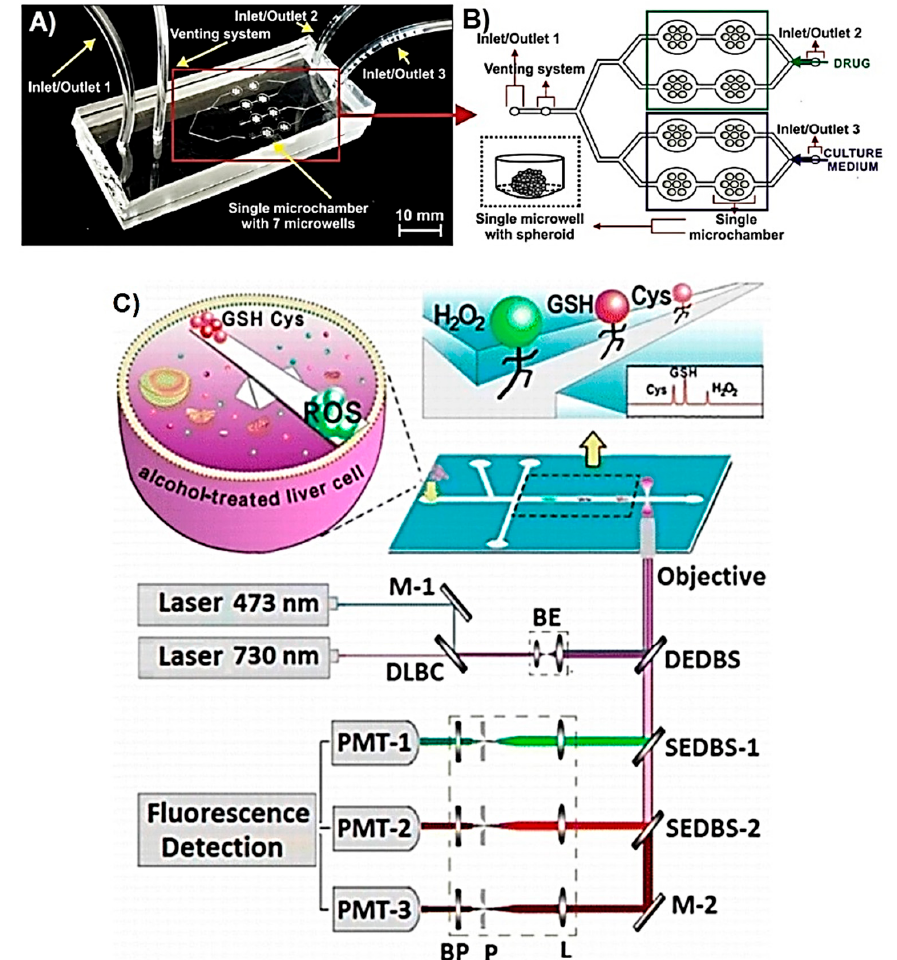
Figure 1. ( A ) The microsystem utilised for the assessment of PDT with the ( B ) scheme of the microsystem construction, reprinted from [48], with permission from Elsevier. ( C ) Schematic representation of multicolour fluorescence detection based microfluidic sensing system with the magnified area showing cell loading and the electrophoresis channel, reproduced with permission from [45], copyright (2016), American Chemical Society.